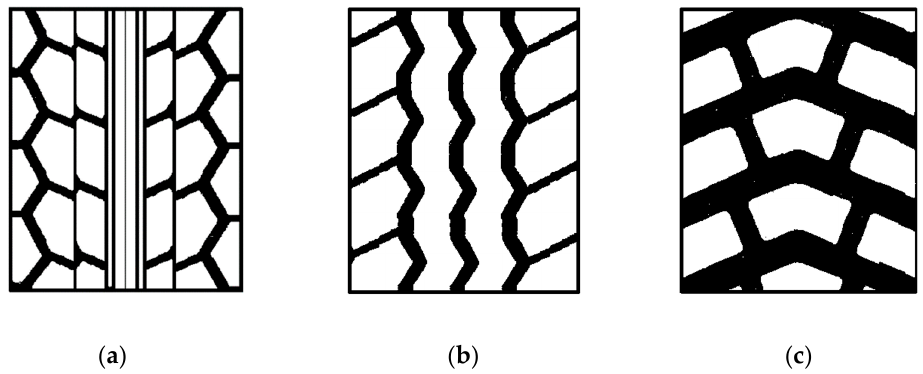
Figure 7. Tire tread patterns: ( a ) for a passenger car; ( b ) for a light-duty truck; and ( c ) for a truck.